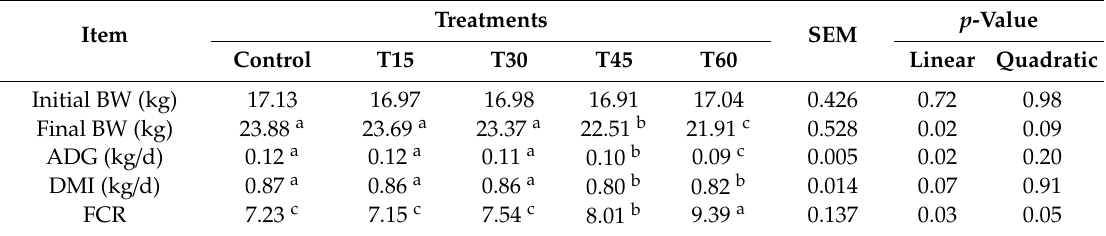
Table 2. Dry matter intake (DMI) and average daily gain (ADG) of fattening Hu sheep fed with mulberry leaf powder.